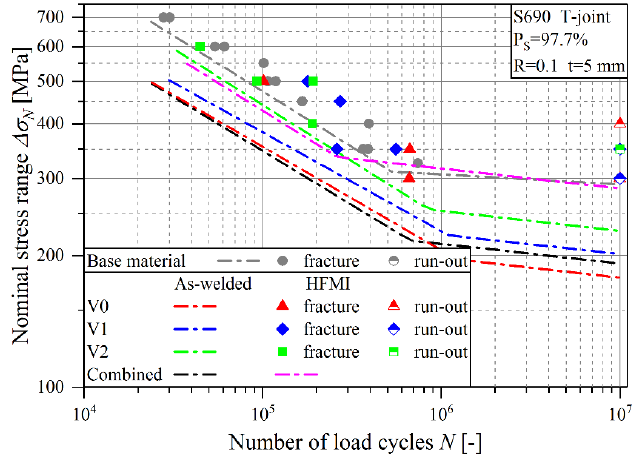
Figure 8. Nominal fatigue test results for HFMI-treated condition.